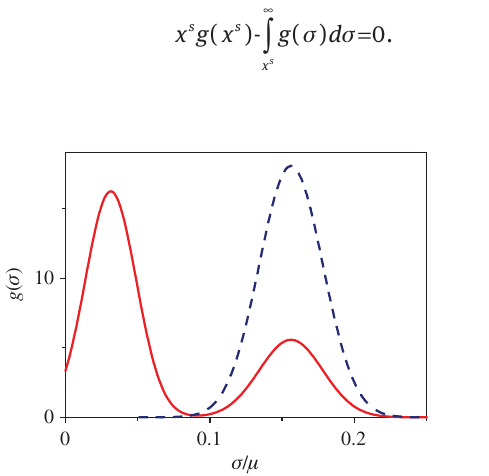
Figure 4 Examples of distribution function of critical shear stresses.